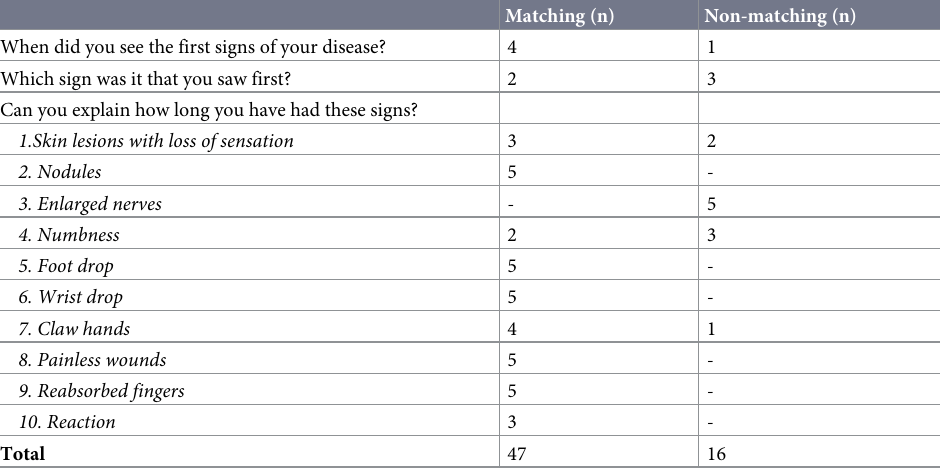
Table 3. Count of matching / non-matching responses in test-retest